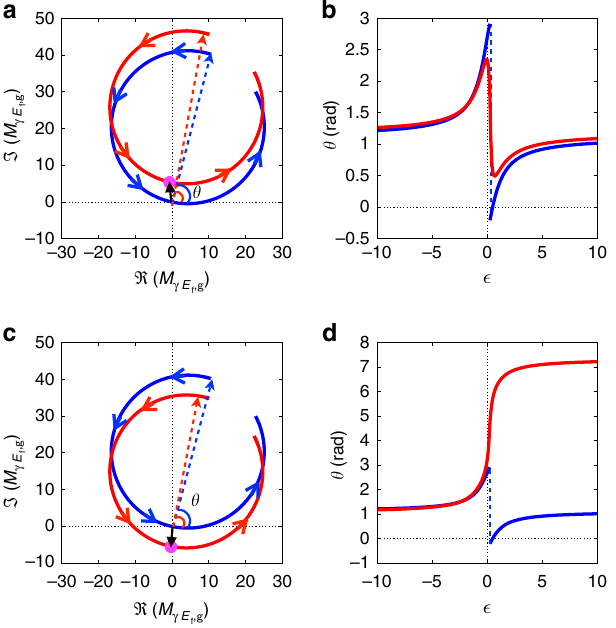
Figure 4 | Influence of multiple channels. ( a ) Complex plane (red circle), its resonant M 1 ð Þ q þ E ð Þ = E þ i ð Þ (blue representation of M g E g E f ; g f ; g circle) and non-resonant M 2 ð Þ (black arrow and magenta dot) components g E f ; g (see equation (11)); y represents here the initial phase at the reduced energy E ¼ (cid:2) 10. The final state has angular momentum L ¼ 0, ‘ ¼ 1 and no q þ E ð Þ = E þ i ð Þ finite pulse effects are included. ( b ) Phase variation of M 1 ð Þ g E f ; g (red line) across the resonance. The resonant (blue line) and M g E f ; g contribution exhibits a p jump across the resonance, while the phase variation of the total amplitude is less than p . ( c , d ) Similar representations (black arrow for the opposite phase of the non-resonant contribution; M 2 ð Þ g E f ; g and magenta dot) is replaced by its complex conjugate. The red circle ( c ) now crosses the horizontal axis and the phase variation ( d ) is 2 p